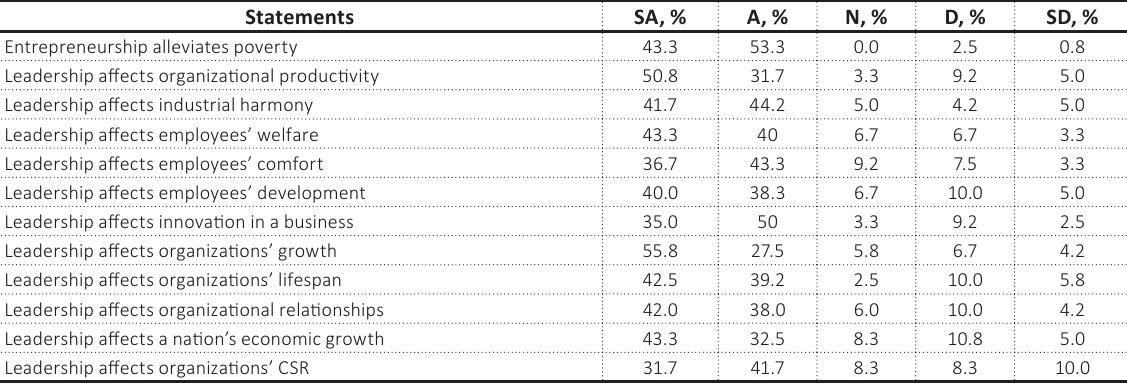
Table 1. Effect of leaders’ behavior on business